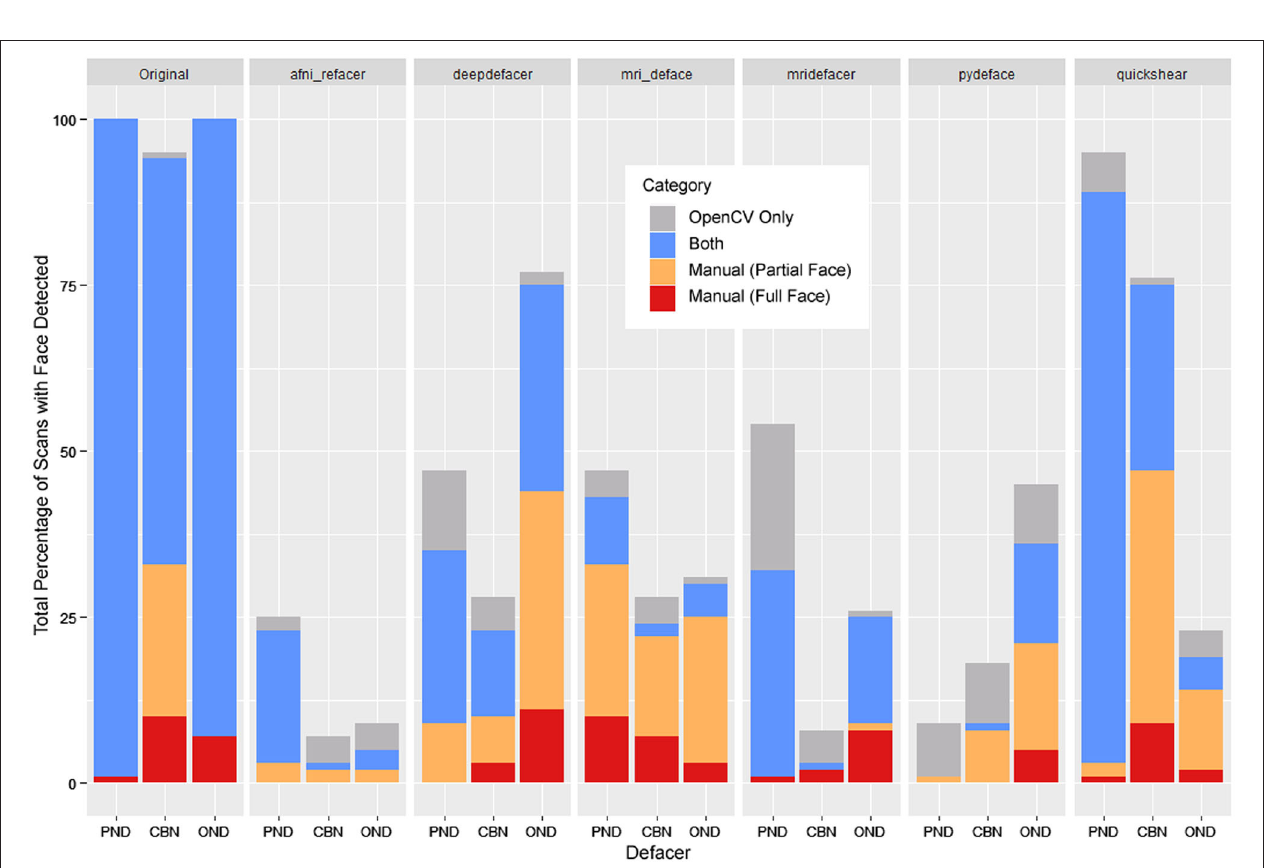
FIGURE 4 | Total percentage of scans where OpenCV or human raters detected a face within the 3D render, segmented by whether a face was detected by both (blue), OpenCV only (gray), or through manual ratings only—subdivided into partial faces (1 feature—orange) and full faces (2 + features—red). FreeSurfer was excluded as none of the scans were determined to have any faces by either manual ratings or